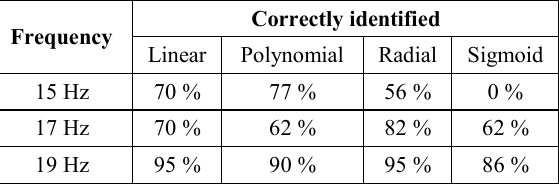
Table 4. Nu-SVM classifier test results.